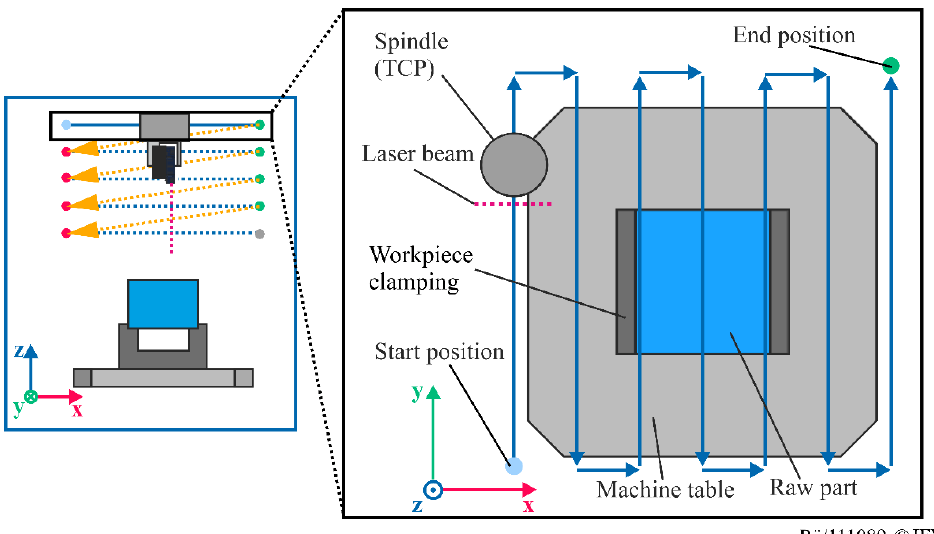
Figure 4. XY-plane sensor path planning.